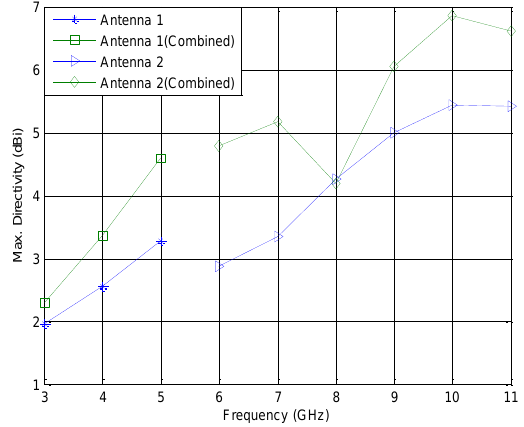
Fig. 15 : Maximum directivity of the antennas.